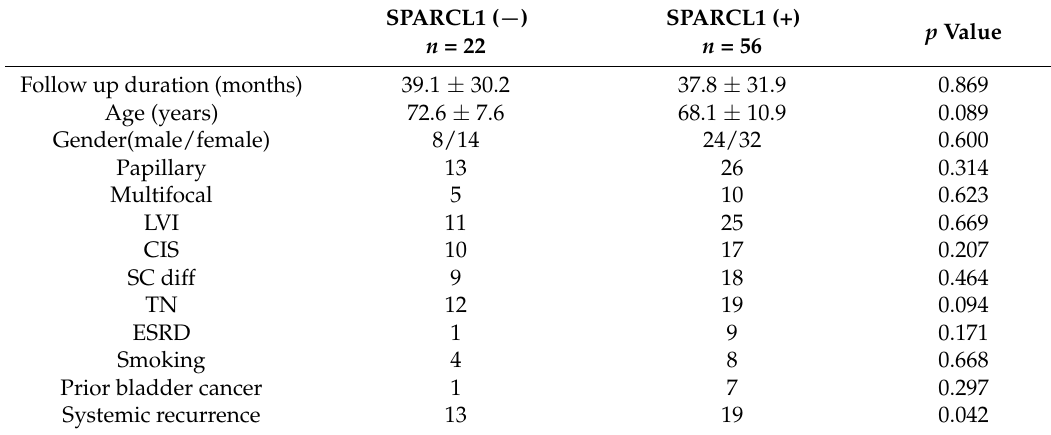
Table 1. Patient characteristics.